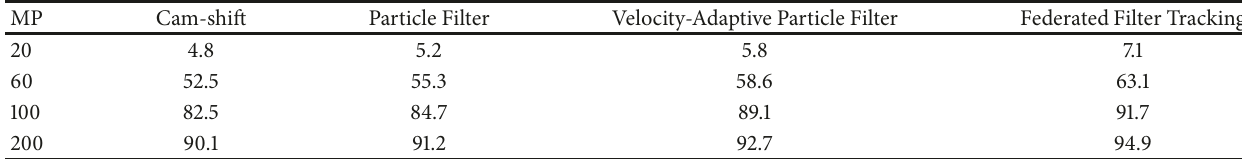
Table 1: Relationship between target tracking accuracy (%) and algorithms.